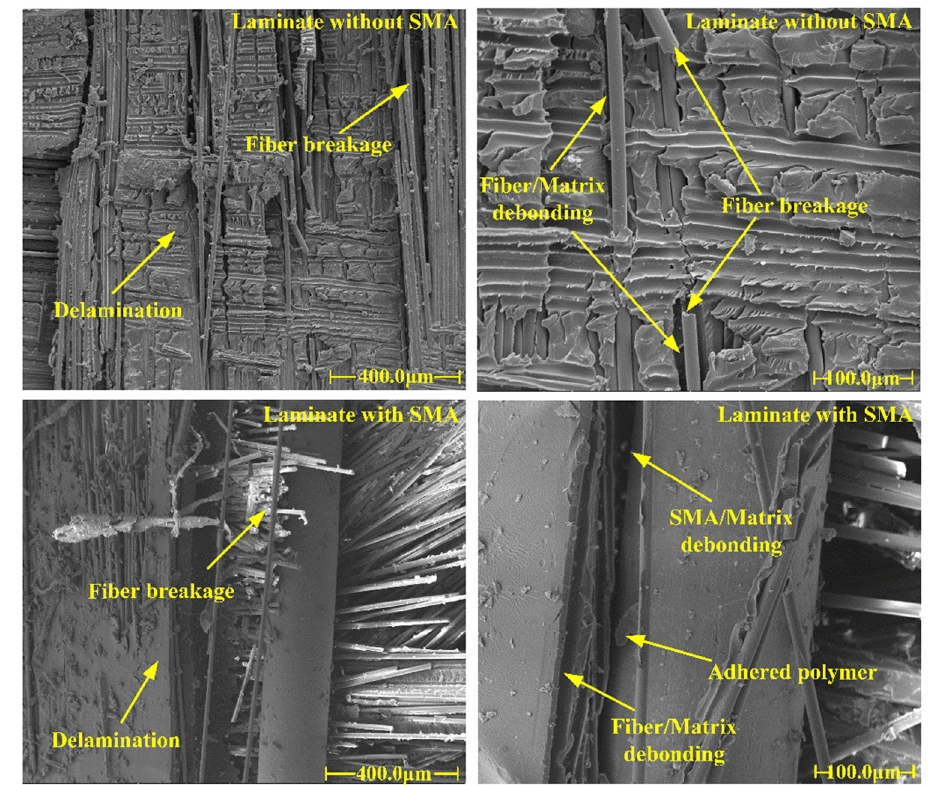
Figure 6: Representative SEM images in the face